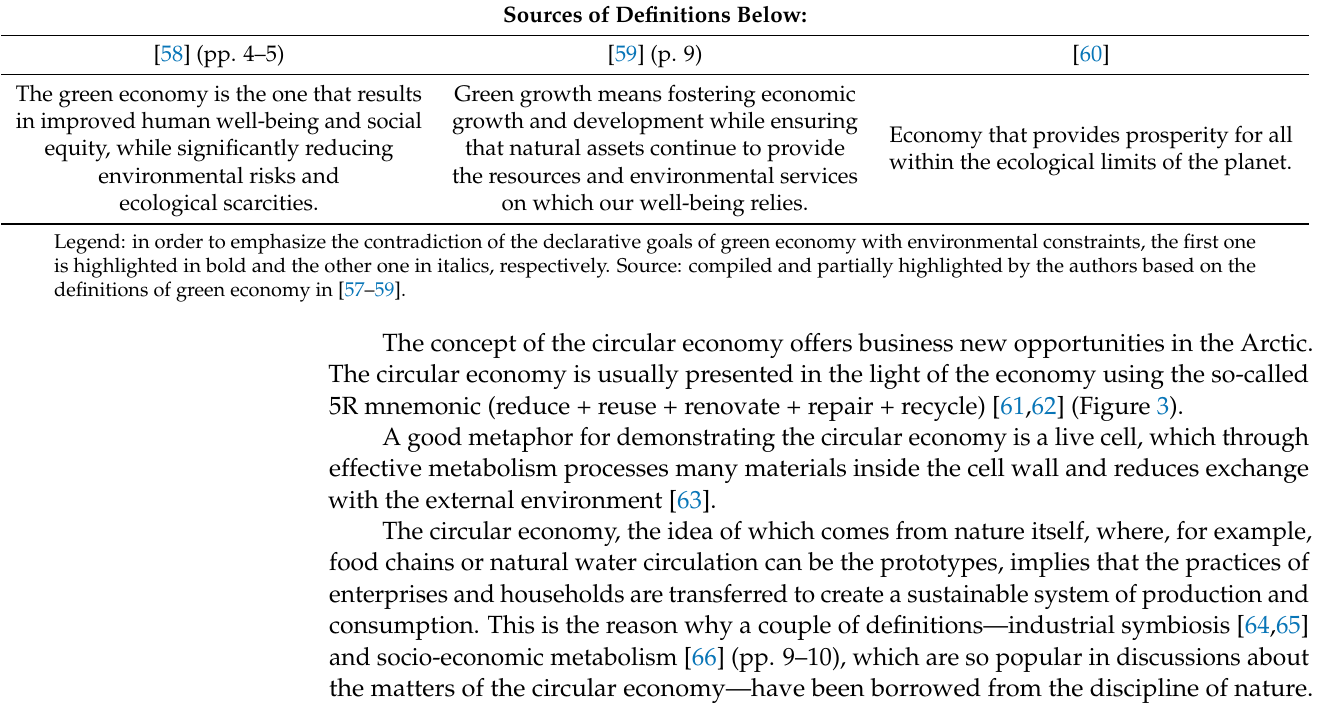
Table 1. Semantic highlighting of immanent contradictions in some definitions of the green economy. Sources of Definitions